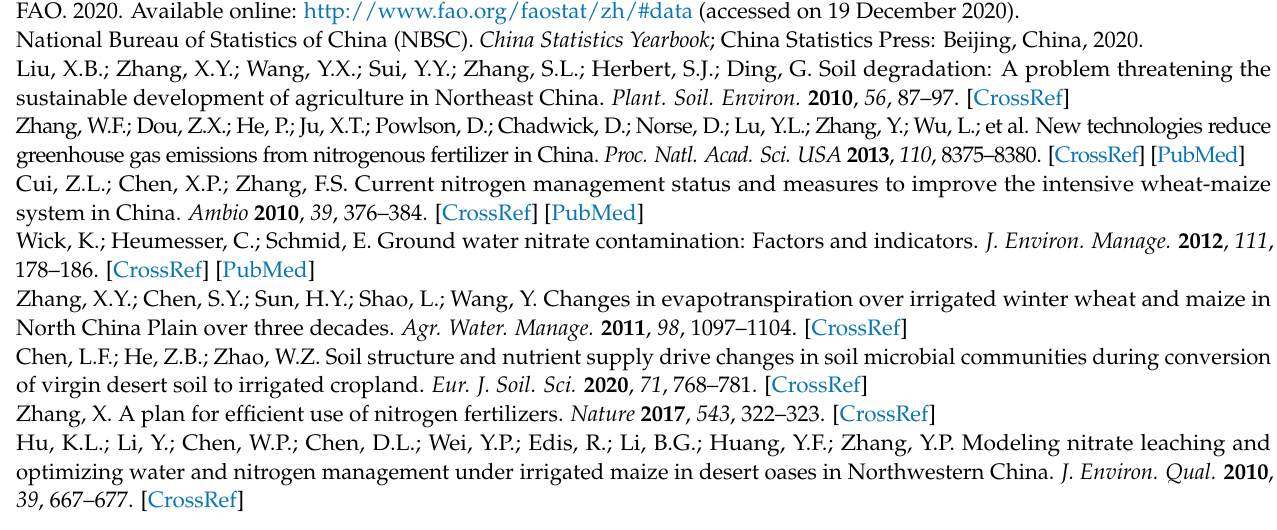
measured soil water content at different depths under N240 treatment in loamy clay soil; Figure S6: Comparison of simulated and measured soil nitrate concentration at different depths under N240 treatment in loamy clay soil; Figure S7: Comparison of measured and simulated leaf area index (LAI) under N240 treatment in loamy clay soil; Figure S8: Comparison of measured and simulated total dry matter (TDM) under N240 treatment in loamy clay soil; Figure S9: Comparison of simulated and measured soil water content at different depths under N240 treatment in Sandy loam soil; Figure S10: Comparison of simulated and measured soil nitrate concentration at different depths under N240 treatment in Sandy loam soil; Figure S11: Comparison of measured and simulated leaf area index (LAI) under N240 treatment in Sandy loam soil; Figure S12: Comparison of measured and simulated total dry matter (TDM) under N240 treatment in Sandy loam soil; Figure S13: Comparison of simulated and measured soil water content at different depths under N168 treatment in loamy clay soil; Figure S14: Comparison of simulated and measured soil nitrate concentration at different depths under N168 treatment in loamy clay soil; Figure S15: Comparison of measured and simulated leaf area index (LAI) under N168 treatment in loamy clay soil; Figure S16: Comparison of measured and simulated total dry matter (TDM) under N168 treatment in loamy clay soil; Figure S17: Comparison of simulated and measured soil water content at different depths under N168 treatment in Sandy loam soil; Figure S18: Comparison of simulated and measured soil nitrate concentration at different depths under N168 treatment in Sandy loam soil; Figure S19: Comparison of measured and simulated leaf area index (LAI) under N168 treatment in Sandy loam soil; Figure S20: Comparison of measured and simulated total dry matter (TDM) under N168 treatment in Sandy loam soil; Figure S21: The relationship between measured and simulated soil water contents, nitrate concentrations, crop yields, and LAI under the validation treatments in Sandy loam soil; Table S1: Soil physical-chemical properties for soil profile in two experimental sites; Table S2: Analysis of significant different for yield and nitrogen uptake under different N rates for two textural soils in 2013 and